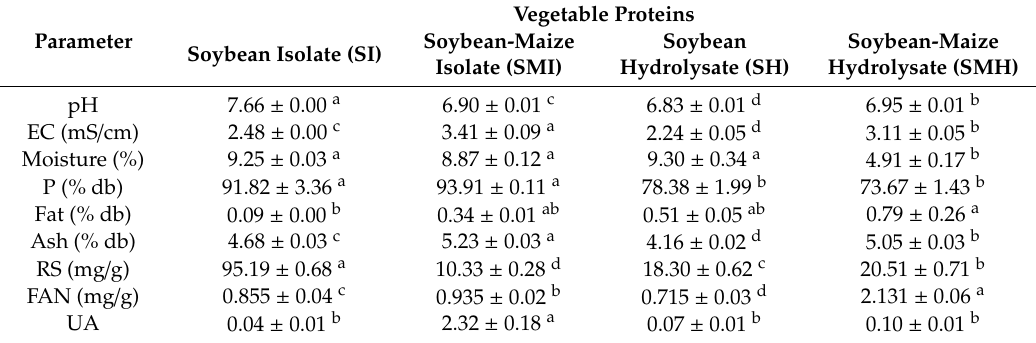
Table 1. Physical and chemical characterization of isolates and hydrolysates of soybean-maize and soybean proteins 1